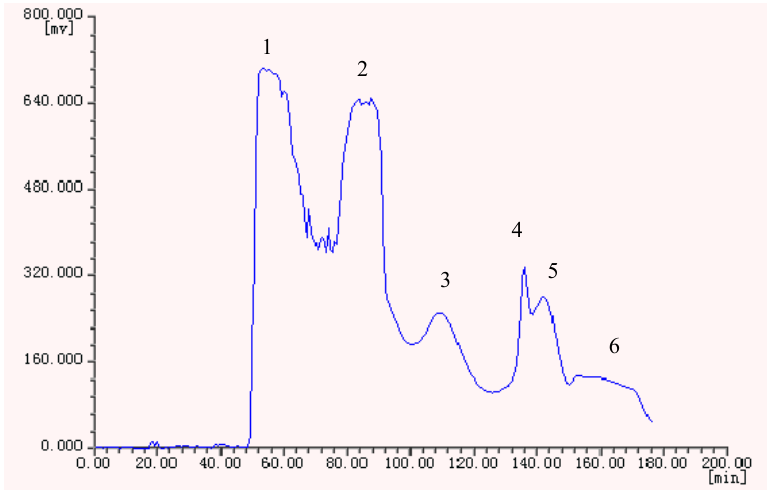
Figure 2. HSCCC chromatogram of the ethyl acetate crude extract from H. halodendron .